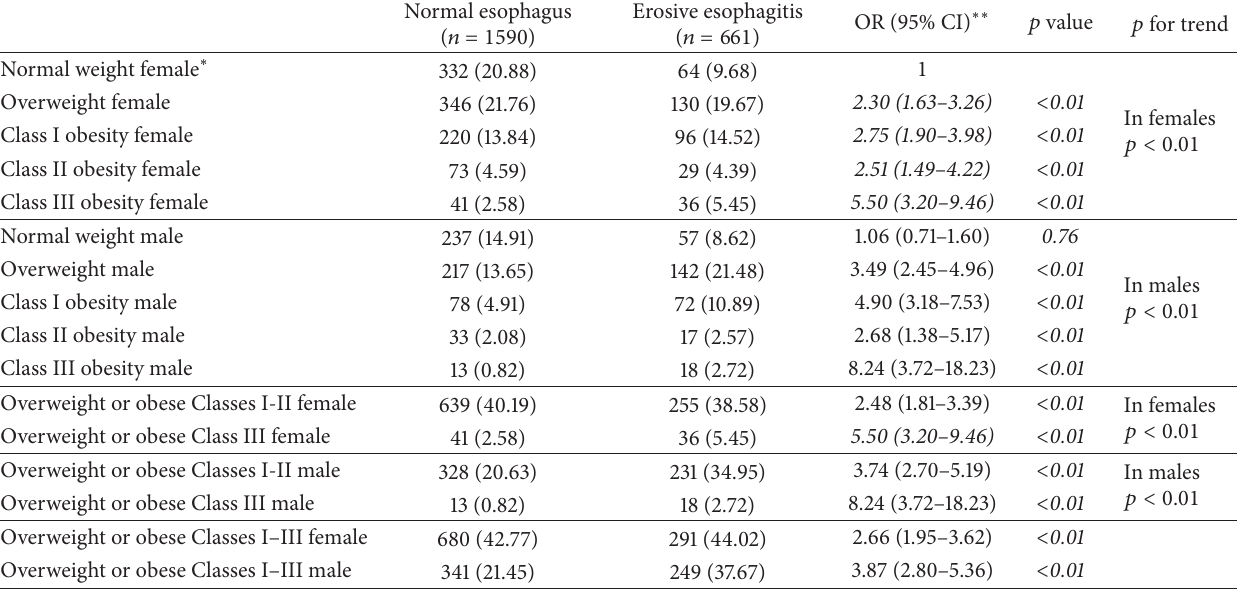
Table 3: Joint effects of obesity and gender on erosive esophagitis ∗ .